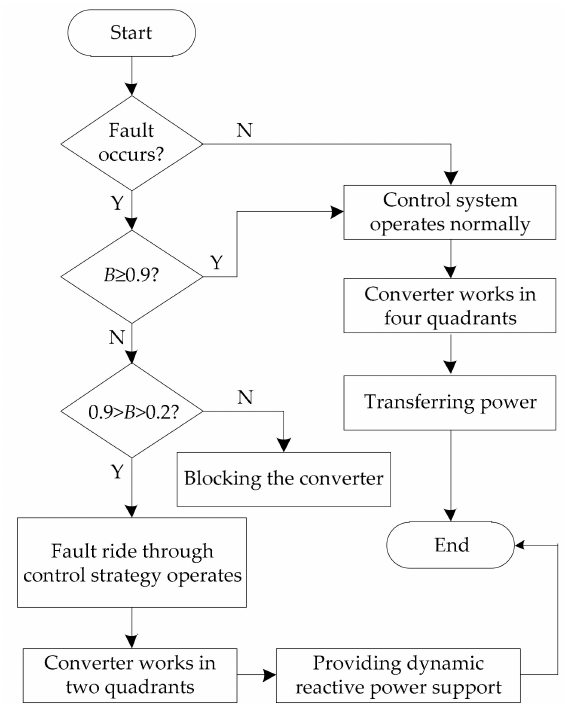
Figure 2. Flowchart of the control system of the MMC-based